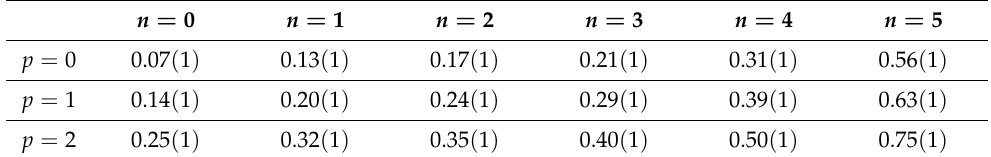
Table 1. Runtime experiment for our algorithm under C for E = 0.8 and different values of n and p (CPU time in seconds). As indicated, the errors are in the last displayed digit, i.e., ± 0.01 s.